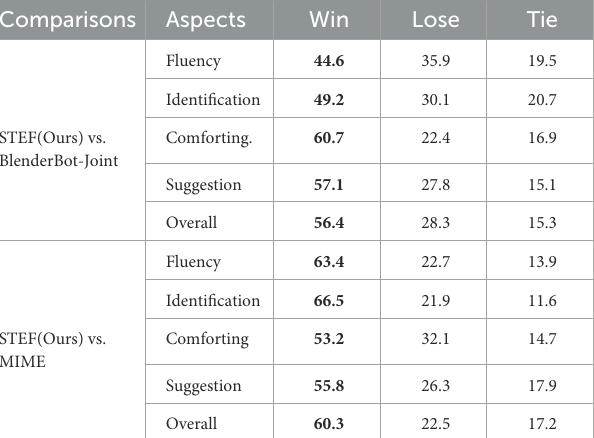
TABLE 2 Performance of human evaluation ( % ). TABLE 3 Examples in the test set of